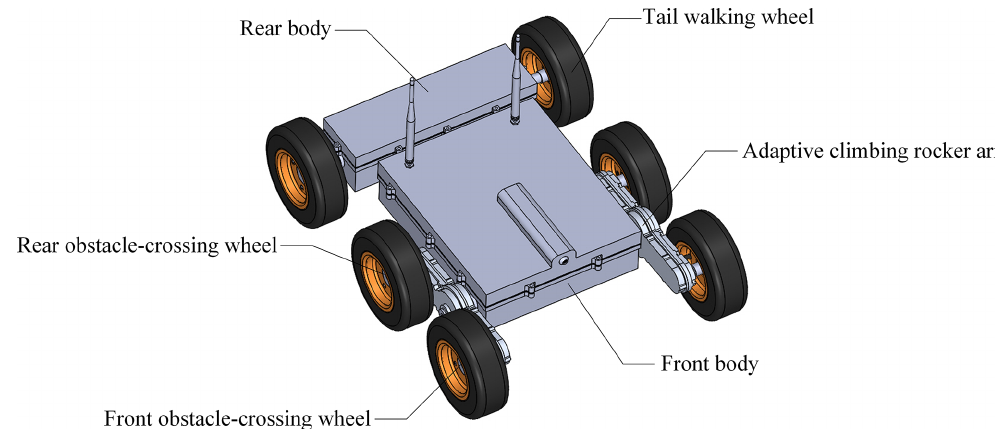
Figure 2. The mechanical structure of the self-adaptive obstacle-crossing six-wheeled robot.